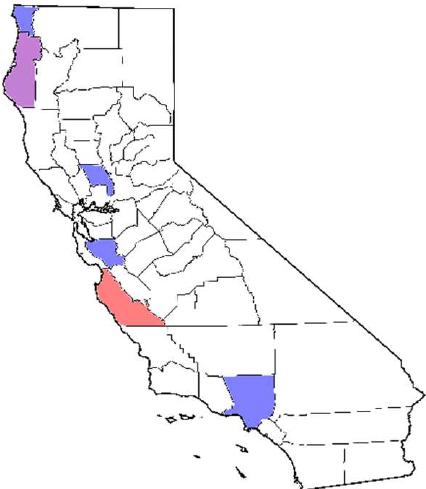
Figure 1. California counties (Co.) where Phytophthora strains were collected for this study, shaded blue for P. cactorum , red for P. pseudotsugae and purple for both species. From north (top) to south (bottom), Del Norte Co. (7 strains), Humboldt Co. (2 strains), Yolo Co. (2 strains), Santa Clara Co. (8 strains), Monterey Co. (11 strains) and Los Angeles Co. (12